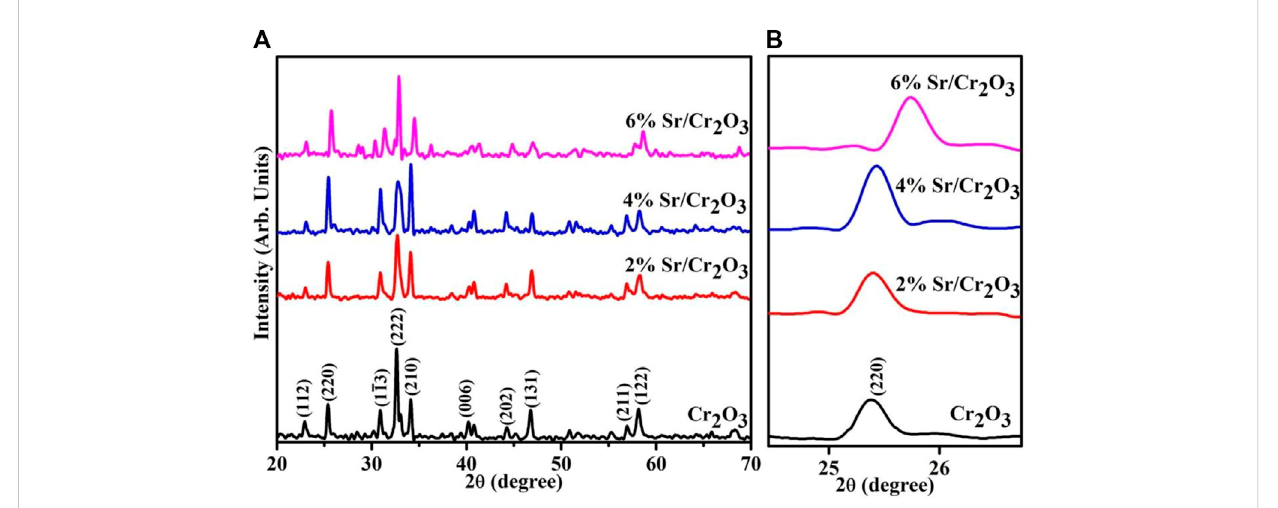
FIGURE 2 (A) XRD patterns of Cr 2 O 3 and Sr-doped Cr 2 O 3 (B) zoomed area of (220)